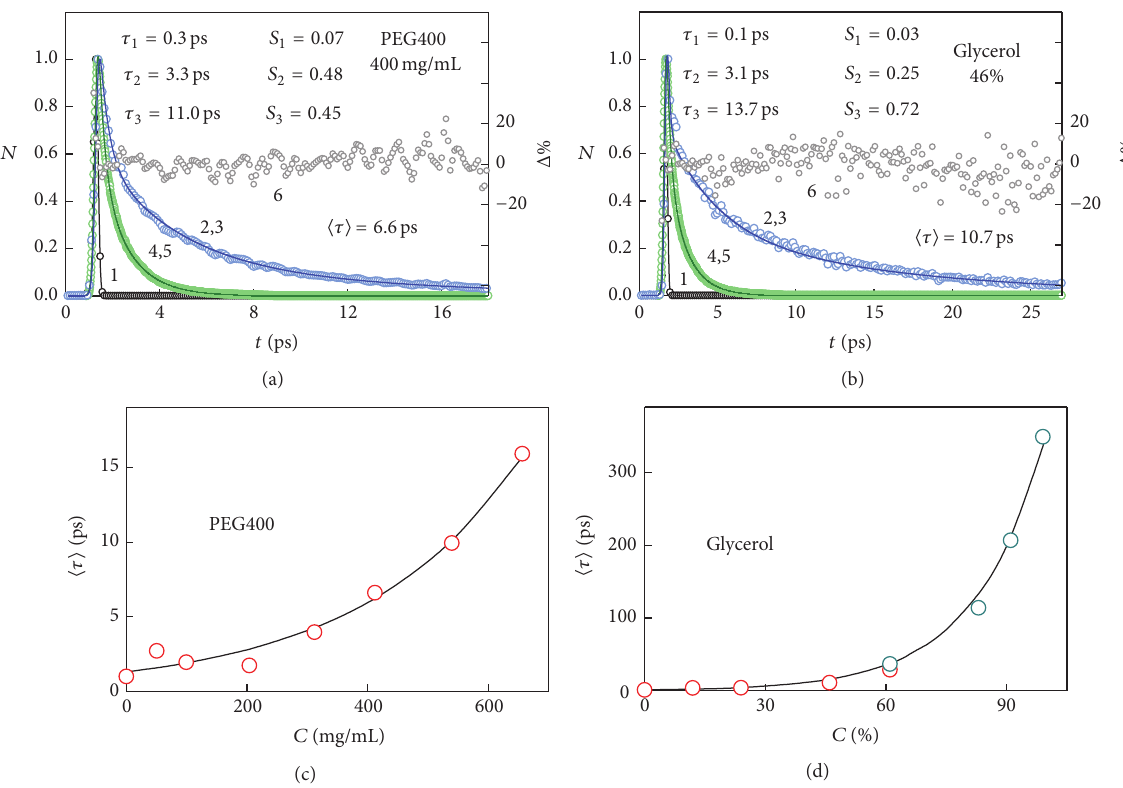
Figure 3: ThT fluorescence lifetime in aqueous solution, in aqueous-glycerol solutions, and in aqueous solutions in the presence of crowding agents. The excitation laser impulse profiles (black curves), experimental fluorescence decay curves (light blue circles), best-fit for a three- exponential decay models (blue curves), and the deviation between the experimental and calculated decay curves (grey circles) for ThT in aqueous solutions in the presence of PEG-400 and glycerol 46% are shown on (a) and (b), respectively. For comparison on (a) and (b) experimental fluorescence decay curves (light green circles) and best-fit calculated fluorescence decay curve (green curves) for ThT in aqueous solution are also represented. 𝑁(𝑡) is the number of registered impulses in the time interval (𝑡 + Δ𝑡) normalized to unity in the maximum. The dependence of ThT fluorescence lifetime on the concentration of PEG-400 and glycerol is shown on (c) and (d), respectively. The results presented on (a), (b), and (c) were obtained with the use of spectrometer FOG100; the data presented on (d) for low concentrations of glycerol were obtained with the use of spectrometer FOG100 (red circles) and for high concentrations of glycerol were obtained with the use of spectrometer FluoTime 300 (blue